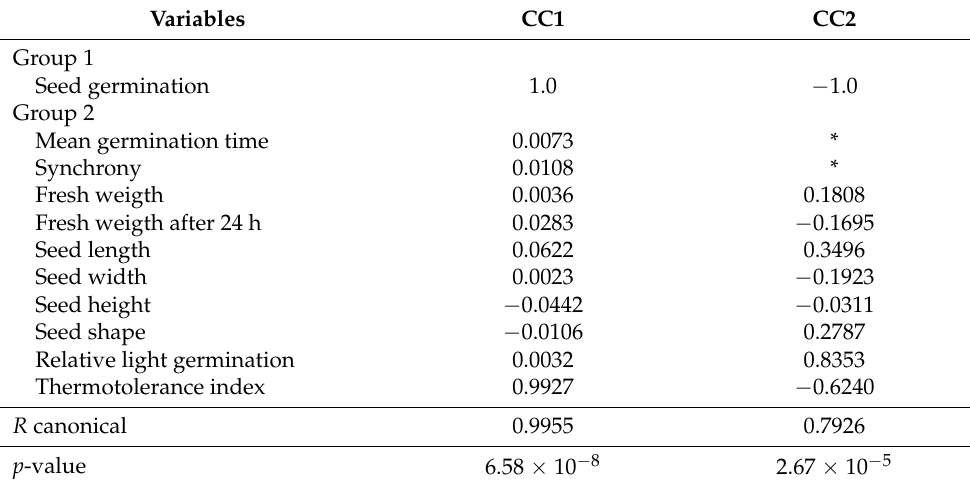
Table 4. Coefficients of canonical correlations (CC) between seed germination in light (CC1) and dark (CC2) related to germination parameters, seed morphological traits, light requirement and thermotolerance in the nine invasive